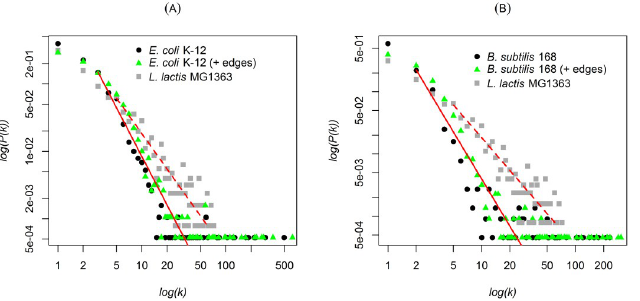
Fig 2. Bench-marking L . lactis MG1363 SPACE network to gold-standards. A: Degree distribution plot for the E . coli K-12 network (black circles). E . coli K-12 (+ edges) represents degree distributions of the network with random edge addition (green triangles). The x -axis shows the log-degree distribution ( k ); y- axis shows the log-probability of the degree distributions. B: The same as in A for the B . subtilis 168 and B . subtilis 168 (+ edges) plots. The criterion for edge addition is described in S2 File. The degree distribution of the L . lactis MG1363 network is plotted as grey squares in panels A and B. The red dotted lines show the power-law fit to the degree distributions of the L . lactis MG1363 network.